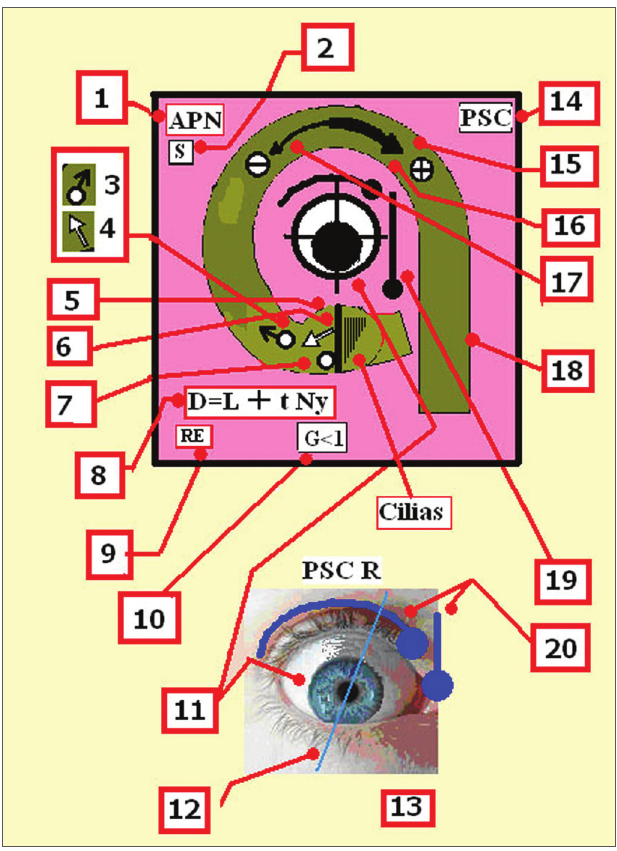
Figure 3. 1-Acronym of the nerve, which innervates the semicircular canal. Ampullar Posterior Nerve. 2- Acronym of the saccule. The saccule shares its innervation with this semicircular canal. 3 -Initial Position of the otolith (t’0) 4- Direction of the tilt of the cupula 5 - Cupula. 6 - Crista.7 - Cupulolithiasis. 8 - Equation that estimates the total migration time of the otoconia crystals D: Duration, L: Latency, tNy: Time of duration of the nystagmus 9 - Acronym for the name which corresponds to the ear 10 - Gain of the semicircular canal. 11 - Position the eye adopts alter stimulating the canal. 12 - Vertical axis of the eye. 13 - Right ear.